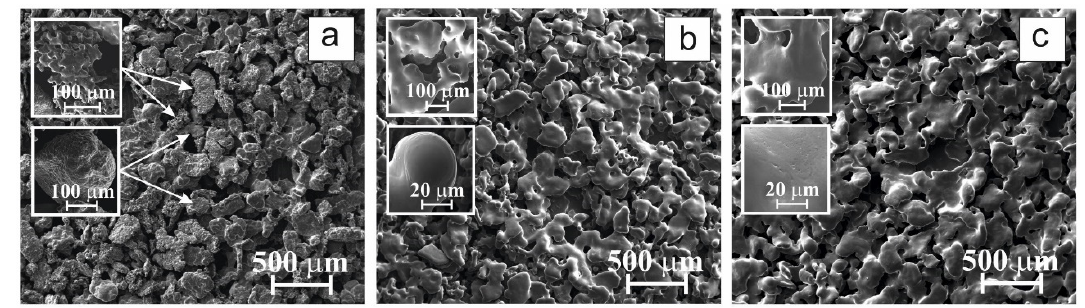
Figure 3. SEM images (SE mode) of sample surface: ( a ) untreated sample TN, and HCPEB-treated samples ( b ) TN-20, and ( c ) TN-30. Table 2. Surface roughness (measured as R z and R a values) of samples as evaluated by surface profilometry.